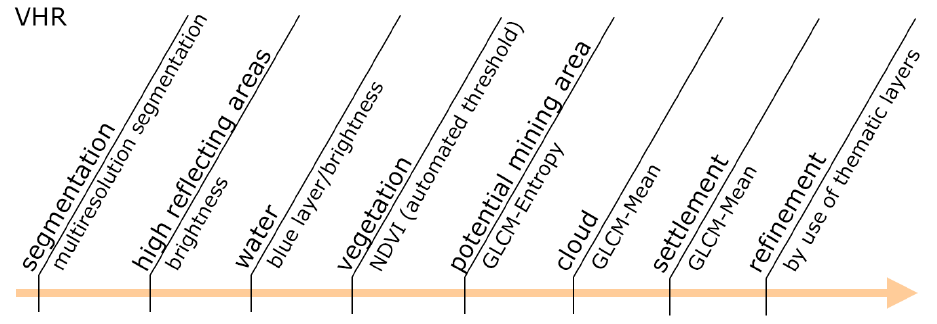
Classification sequence for VHR analysis with class (above line) and corresponding features/classification rules (below line) implemented in the rule